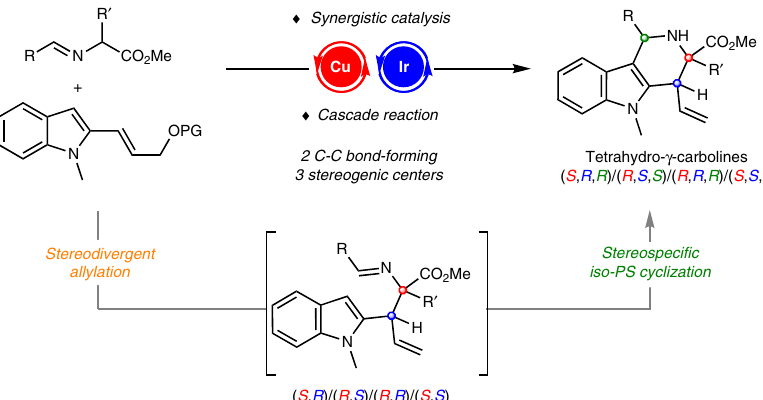
Fig. 2 Reaction design. Stereodivergent synthesis via synergistic catalytic asymmetric cascade allylation and iso -Pictet-Spengler cyclization